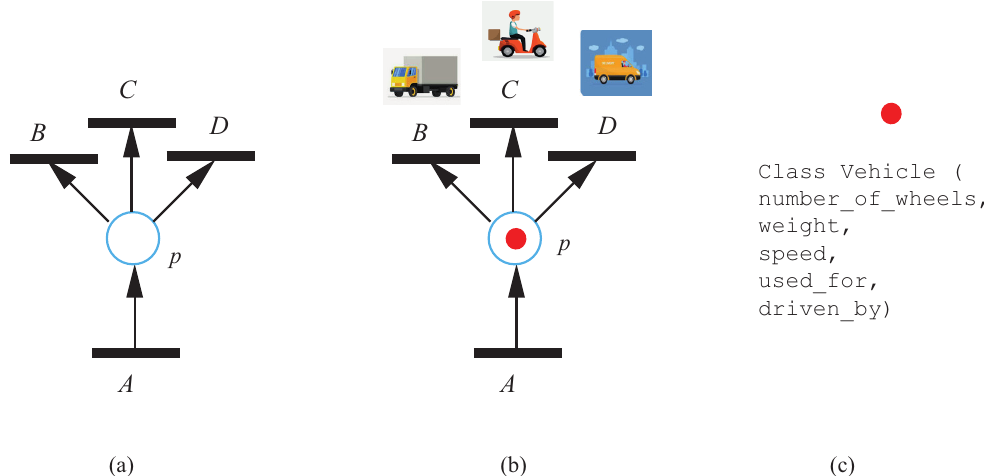
Figure 1. ( a ) Modeling Scenario 1, ( b ) the effects after a successor transition has been chosen, ( c ) pseudo-code for an entity